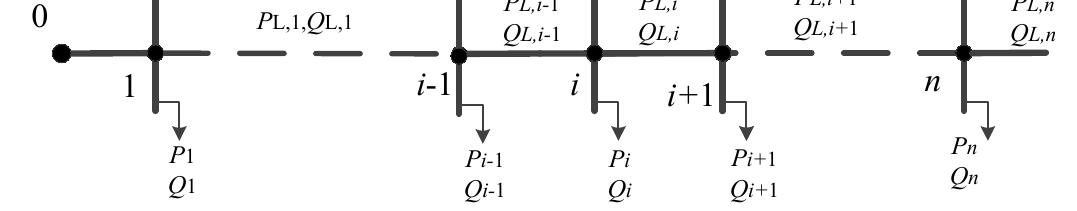
Figure 2. Network topology diagram of LVDN.